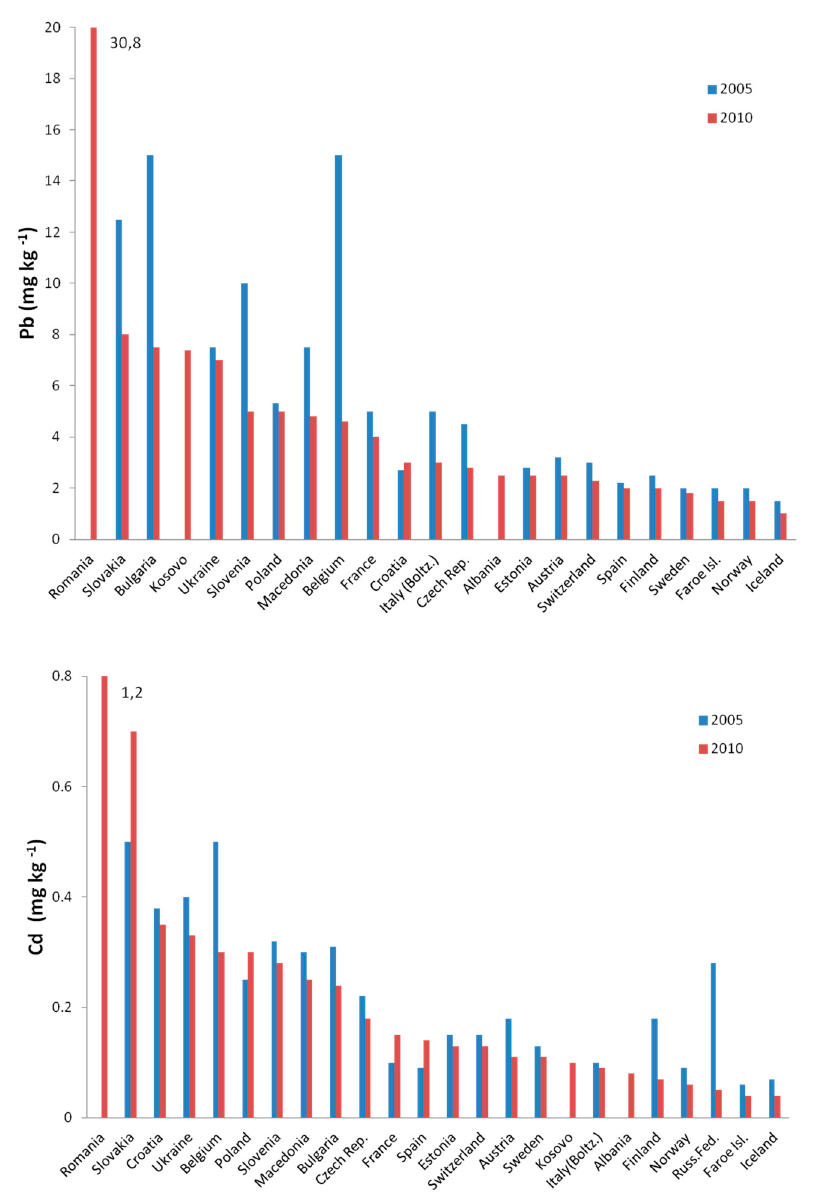
Figure 1. Comparison of lead and cadmium concentrations in mosses (median) in 2005 and 2010, in European countries (adapted from [43]).